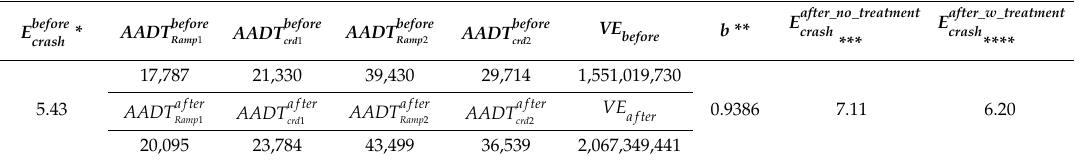
Table 3. EB method-based before-and-after crash frequency comparison at Intersection 1 (SH 80 (Hopkins Street) at IH 35).